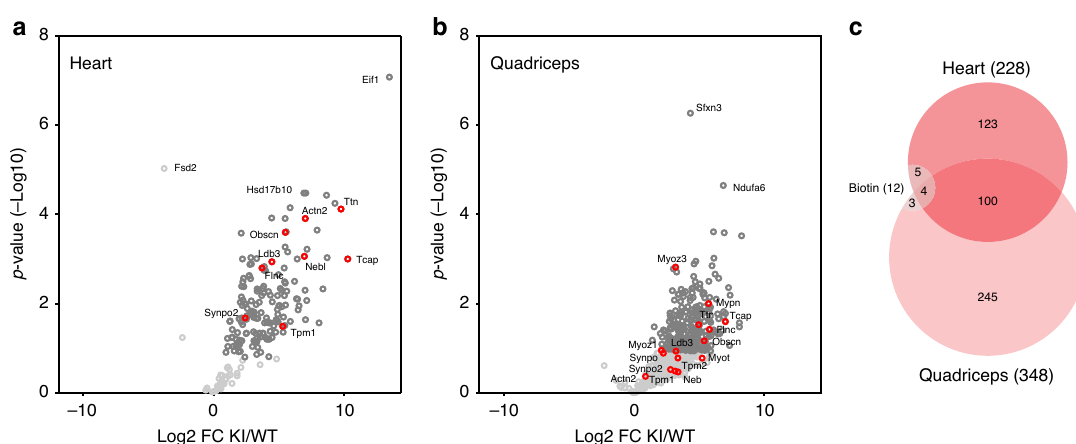
Fig. 3 The sarcomeric proteome in the heart and skeletal muscle. a – c Fold change and p -value of proteins that co-purify with biotinylated proteins after streptavidin pulldown of TiZ-BioID knock-in vs. WT hearts ( a ) and quadriceps ( b ) with known Z-disc-associated proteins in red, signi fi cantly enriched in dark gray. c The adult sarcomeric proteome comprises >450 proteins, 100 of them shared between heart and quadriceps. Less than 5% of proteins retrieved were biotinylated. Source data are provided as a Source Data fi